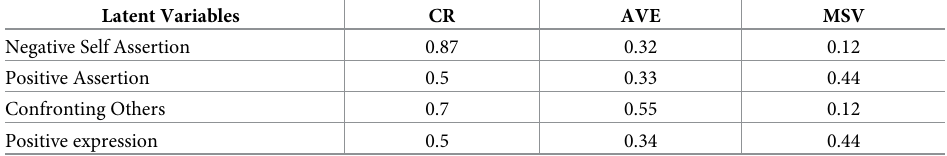
Table 3. Convergent validity, discriminant validity and composite reliability of the final CFA model of Arabic version of the Irish Assertive